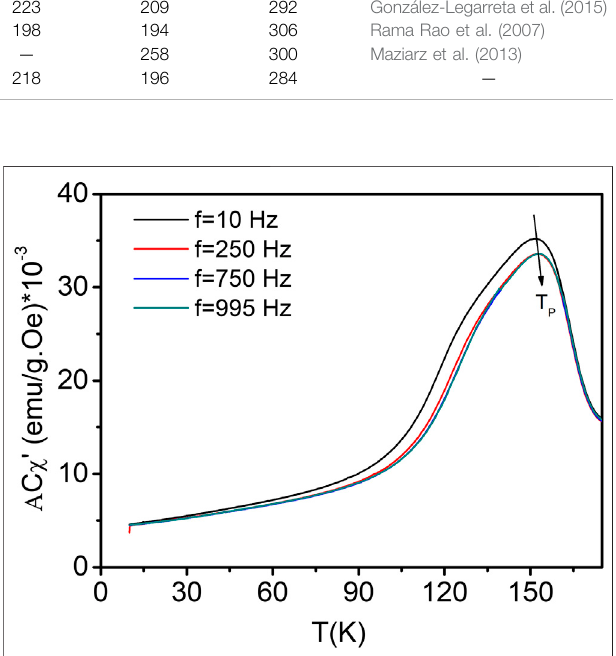
FIGURE 6 | Temperature dependence of the real part of AC susceptibility ( χ ʹ ) measured at different frequencies for the present ribbons.